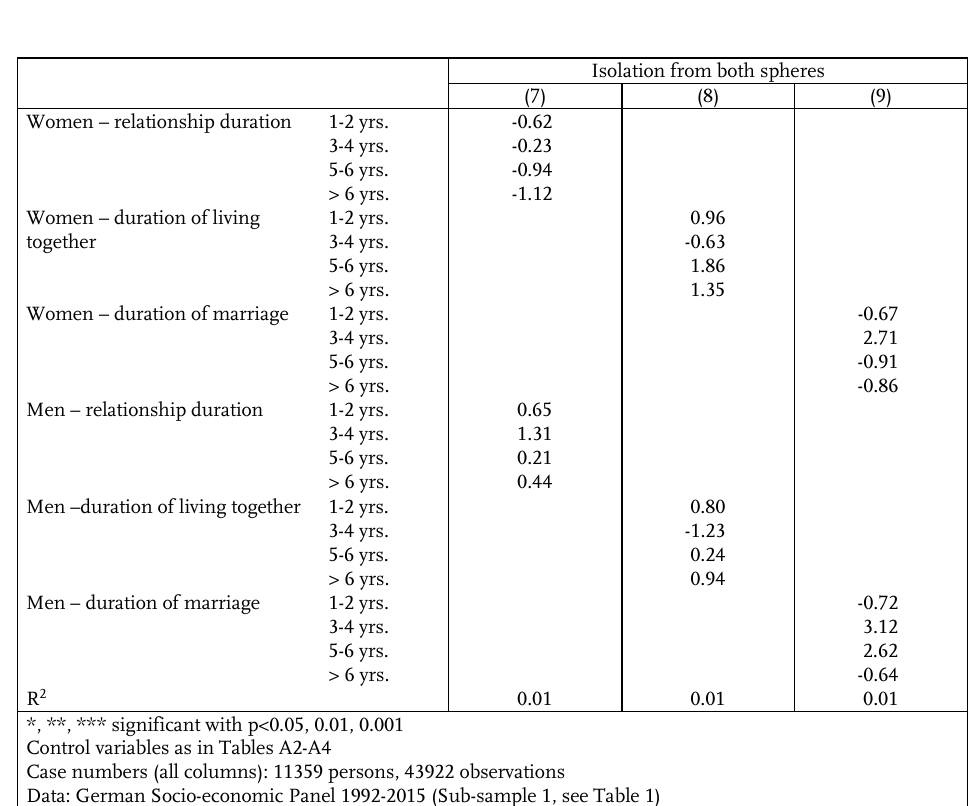
Table A.6 : Time-effects of partner relationships on social isolation (linear-probability models with fixed effects, percentage points)